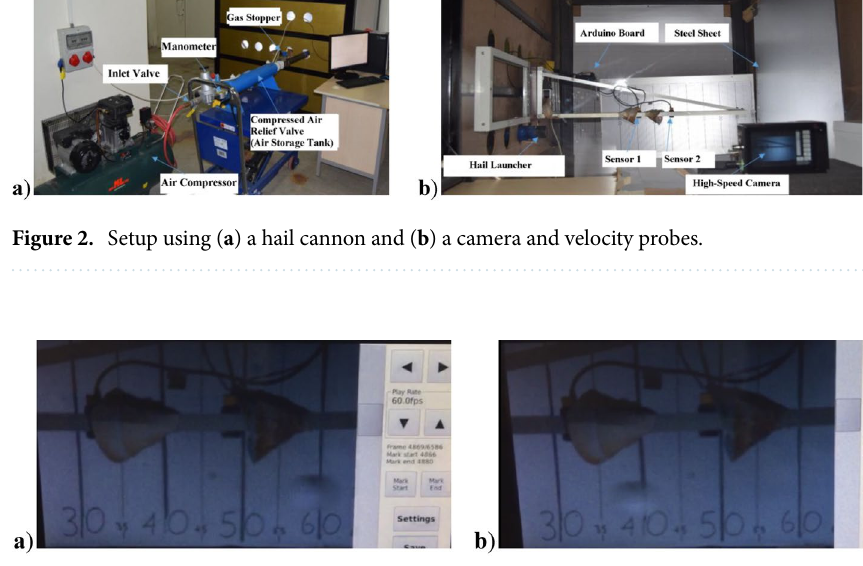
Figure 3. Images of hailstones made of PVA with a diameter of 38 mm ( a ) before impact and ( b ) after